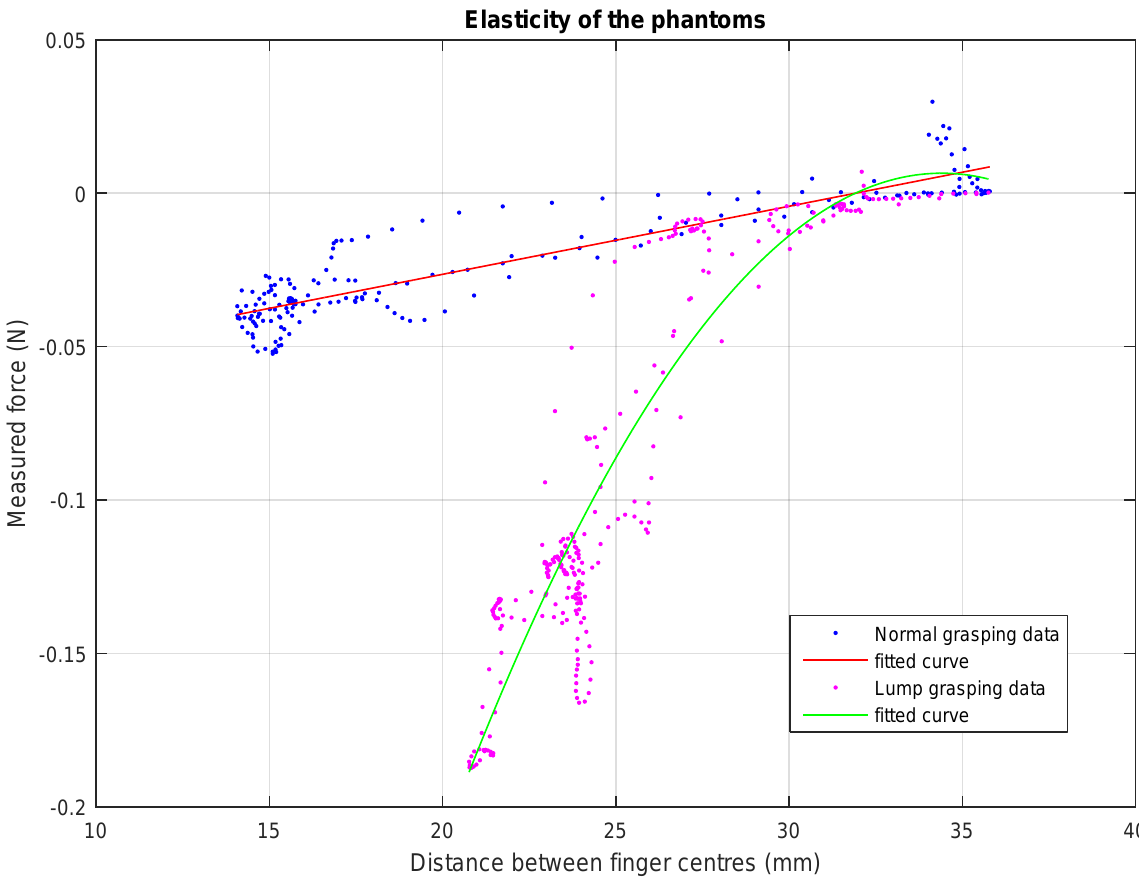
Figure 8. Displacement-force plots of the foam phantoms, showing different